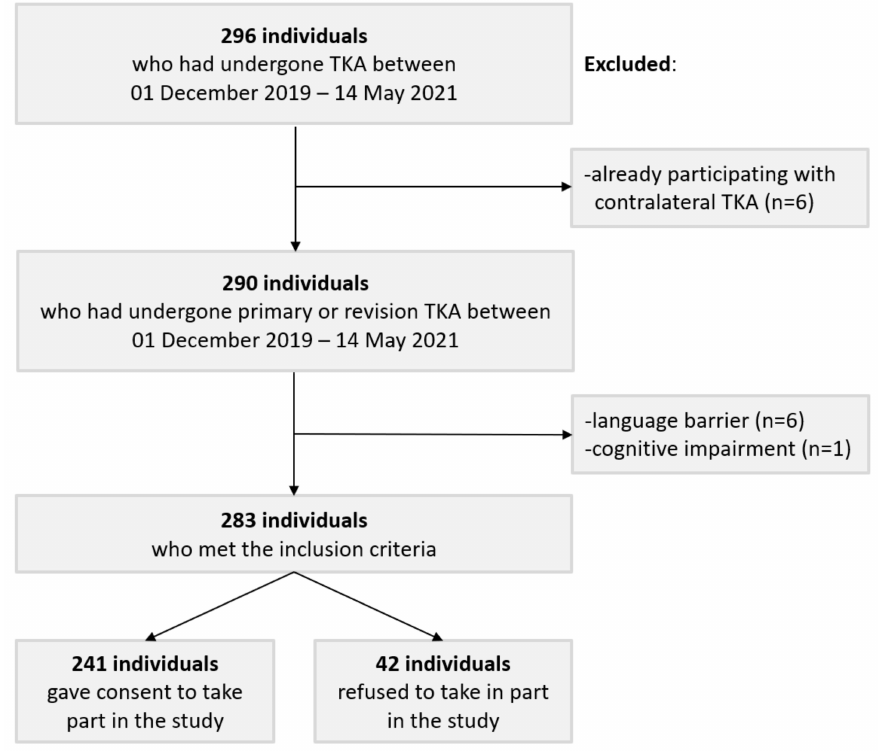
Figure 1. Flowchart of the study